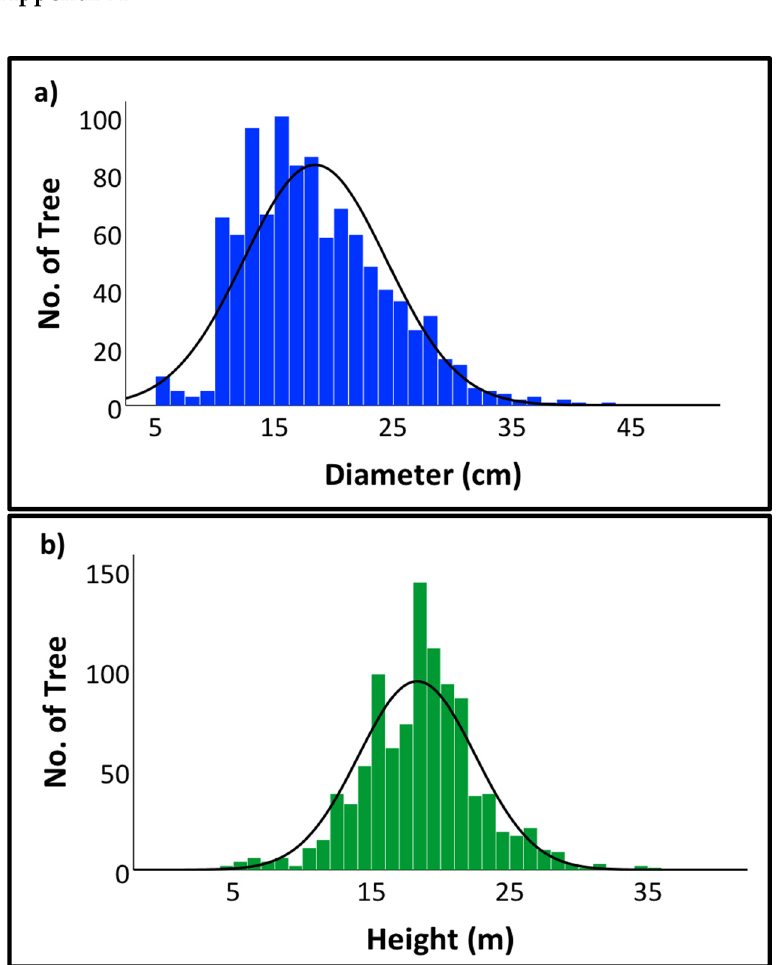
Figure A1. Histogram of ( a ) the diameter and ( b ) the height distribution of 1000 standing trees in the 2-ha plot of Sungai Pulai Forest Reserve.